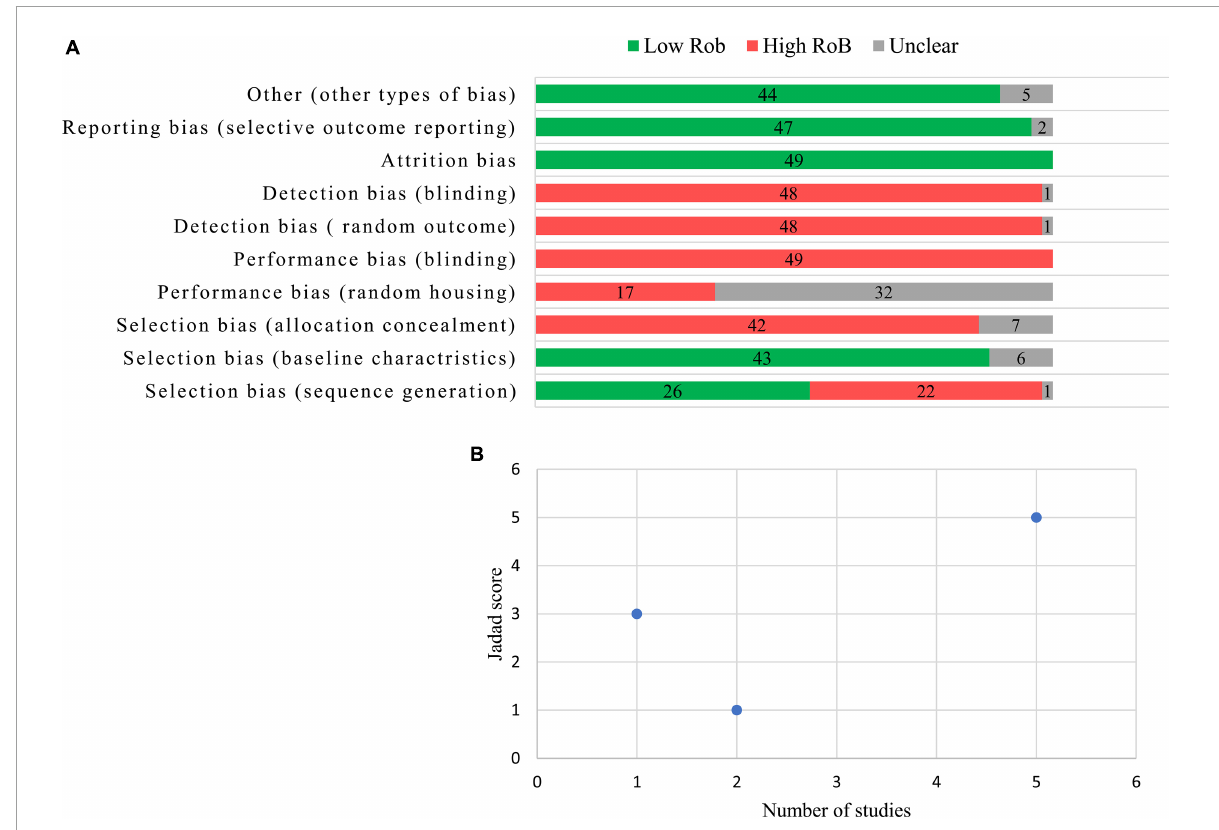
FIGURE2 Results from the risk of bias assessment according to the Systematic Review Centre for Laboratory Animal Experimentation (SYRCLE) authors’ judgment about each risk of bias item (A) and the quality assessment of clinical trials according to the Jadad score (B)